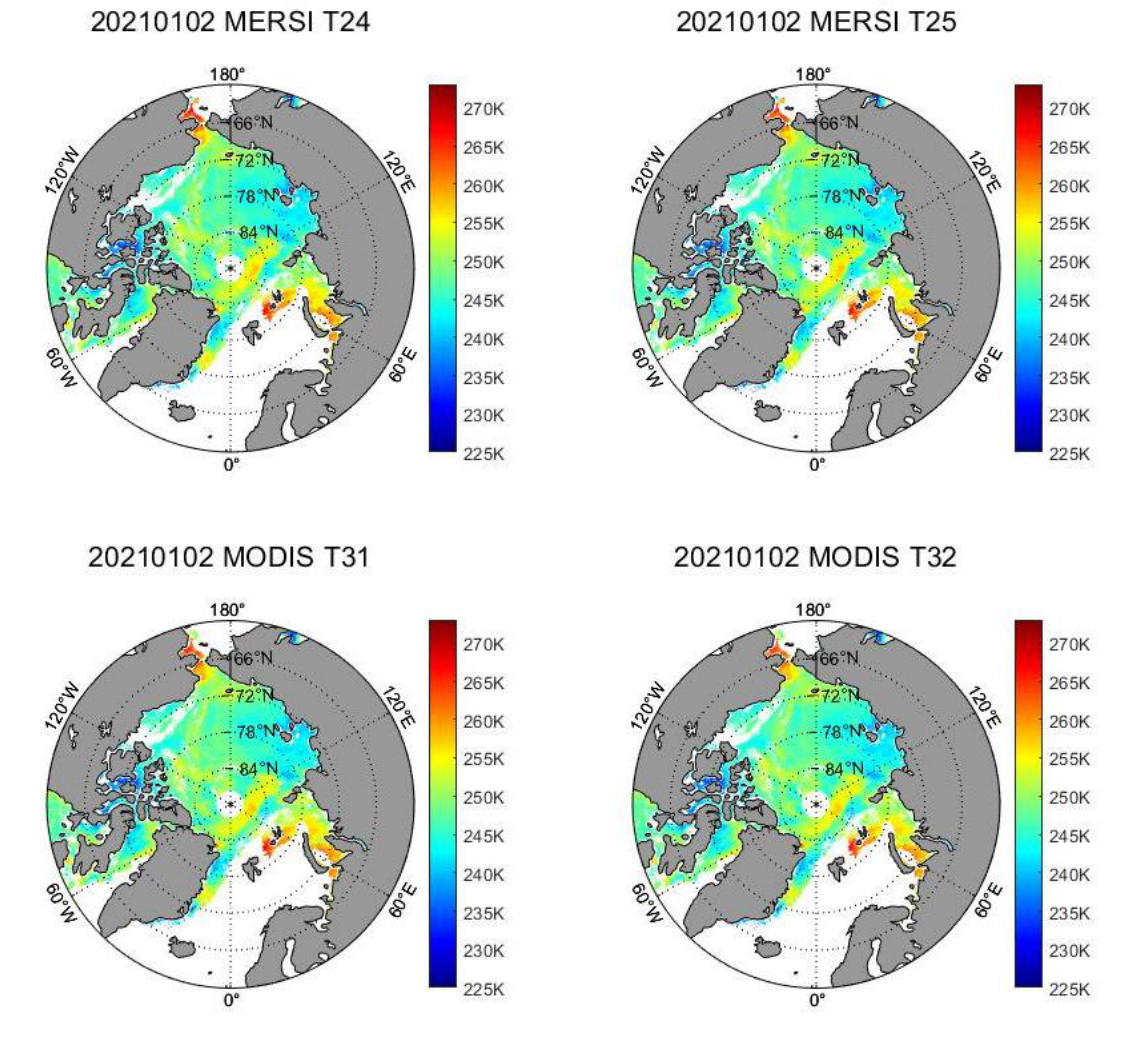
Figure 4. Comparison of distribution maps of MERSI (channels 24 and 25) and MODIS (channels 31 and 32) daily average thermal infrared T b data on 2 January 2021.